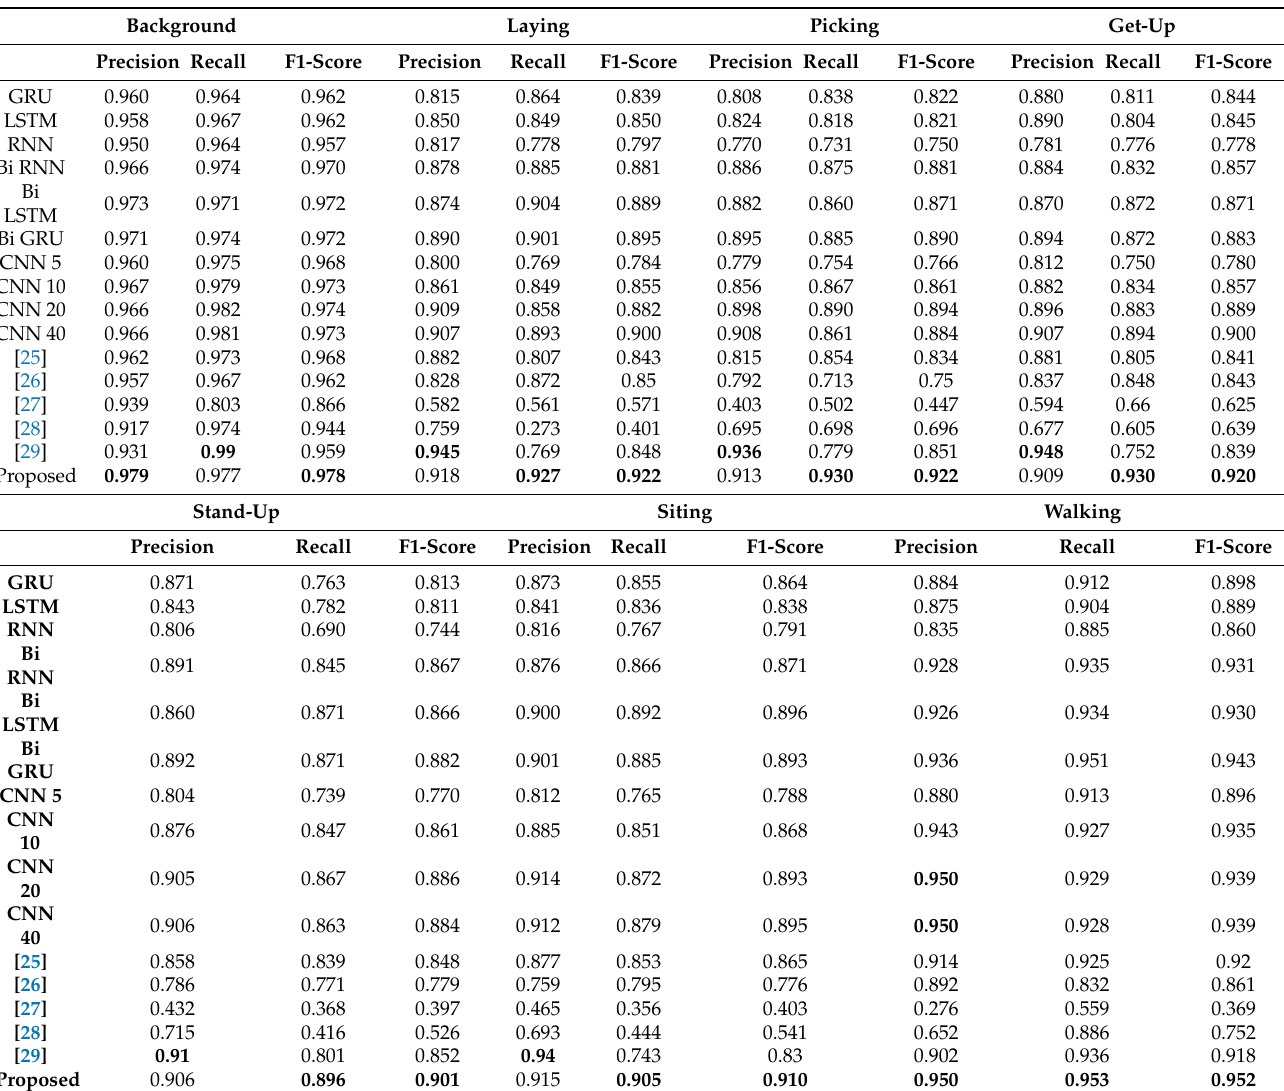
Table 3. Comparison with other DL models for evaluating performance improvement.